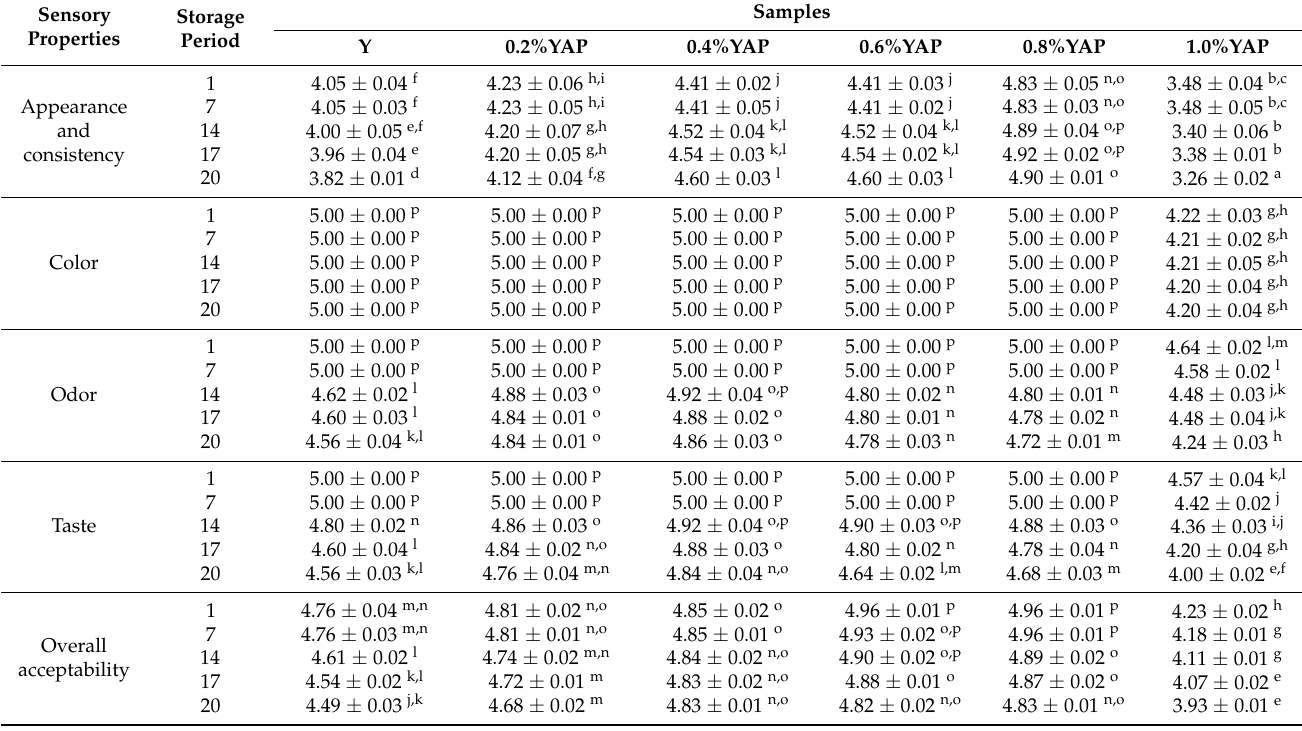
Table 5. Sensory properties (score) and evolution of yogurt with apple pomace powder, during